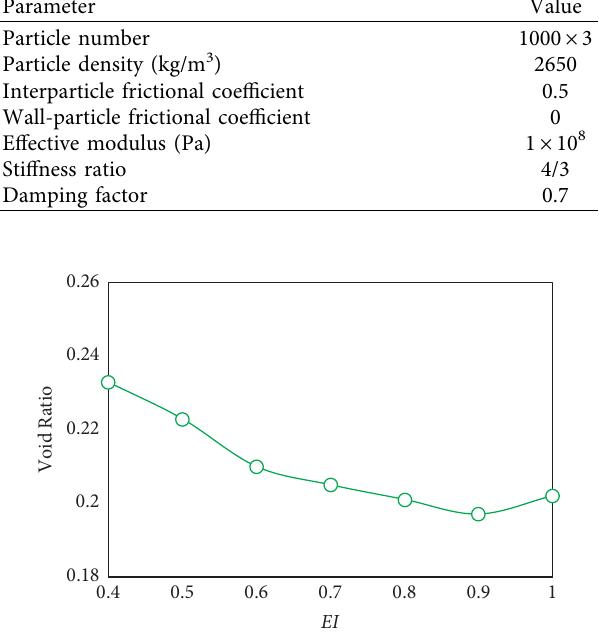
Figure 14: Change curves of the void ratio with respect to elongation.